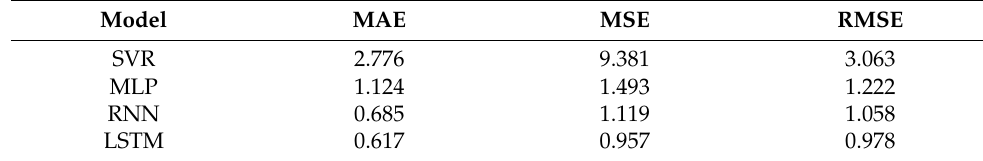
Table 4. HBEA prediction